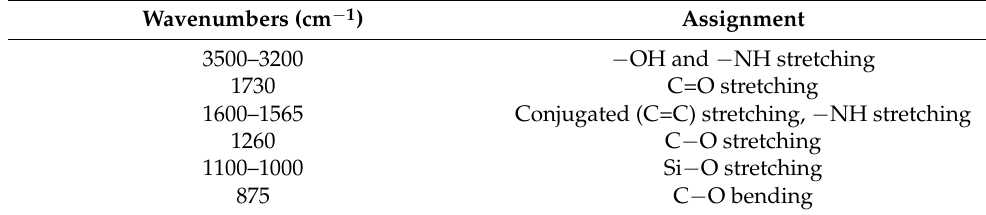
Table 3. FTIR signals and vibrational assignments for